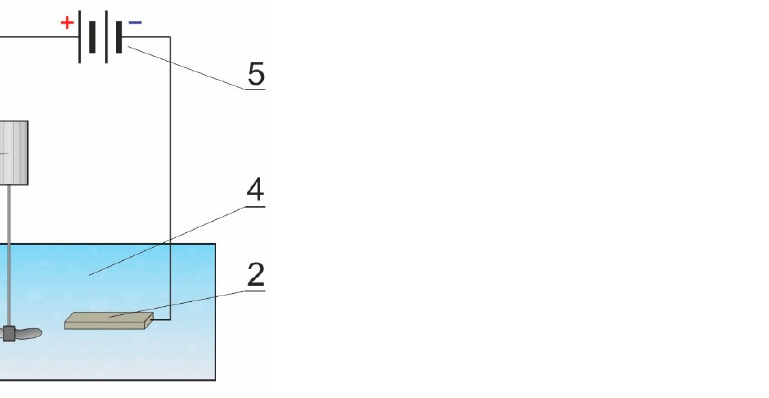
Table 1. Total experiment